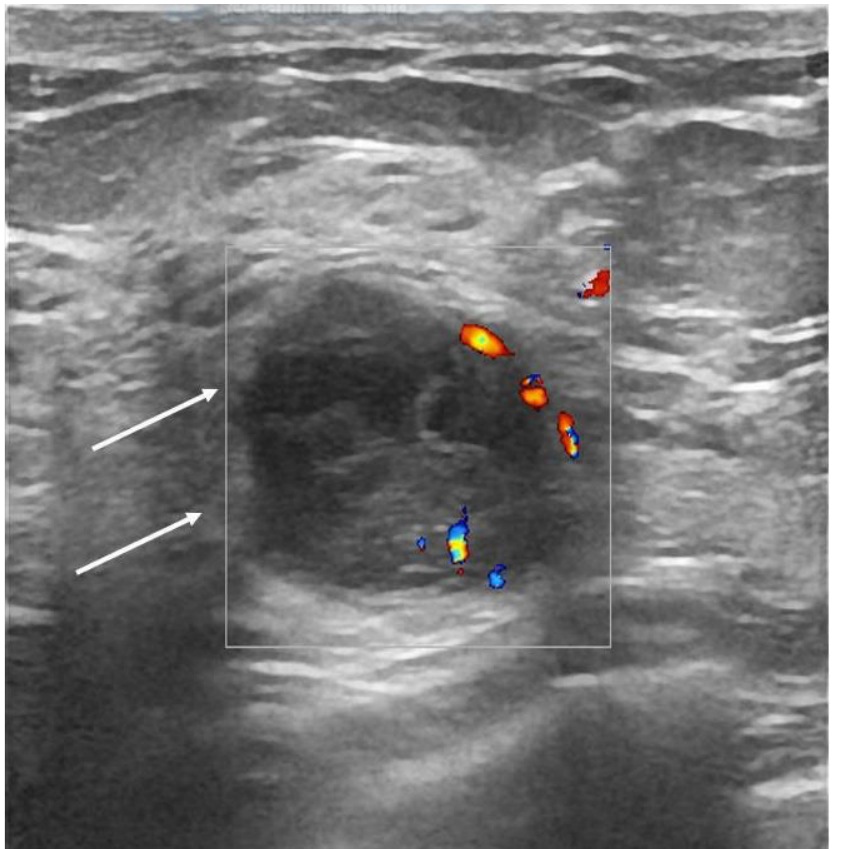
Figure 4. 42-year-old RAD51C mutation carrier patient with right breast cancer. There is an oval, hypoechoic mass with indistinct margins (arrows), parallel orientation compared to skin, with internal vascularity and soft elastography appearance (TSUKUBA score 2). Pathology: IDC-NST, ER/PR/HER2-negative, grade 3, Ki67 = 80%.